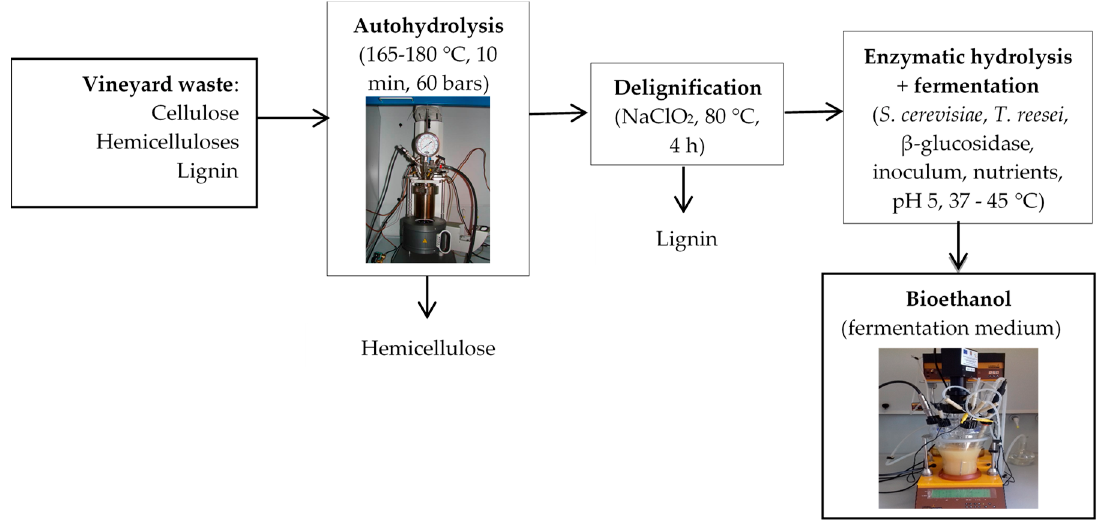
Figure 12. Schematic representation of the bioethanol production from vineyard wastes.